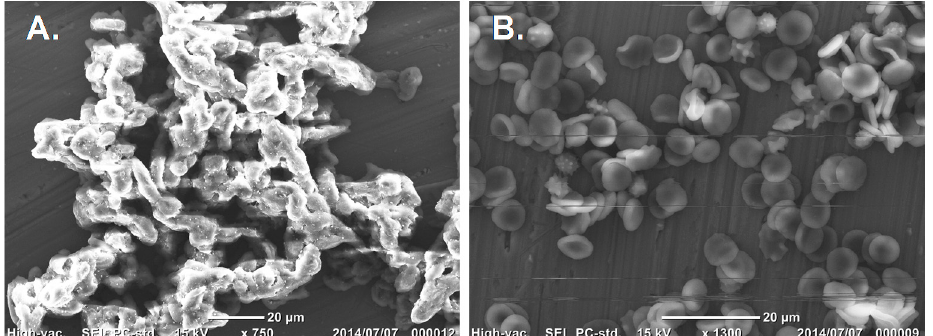
Figure 4. SEM imaging of RBCs agglutinated by AKL in the presence of SLO. ( A ) AKL-induced hemagglutination; ( B ) negative control (RBCs without AKL or SLO). Scale bars: 20